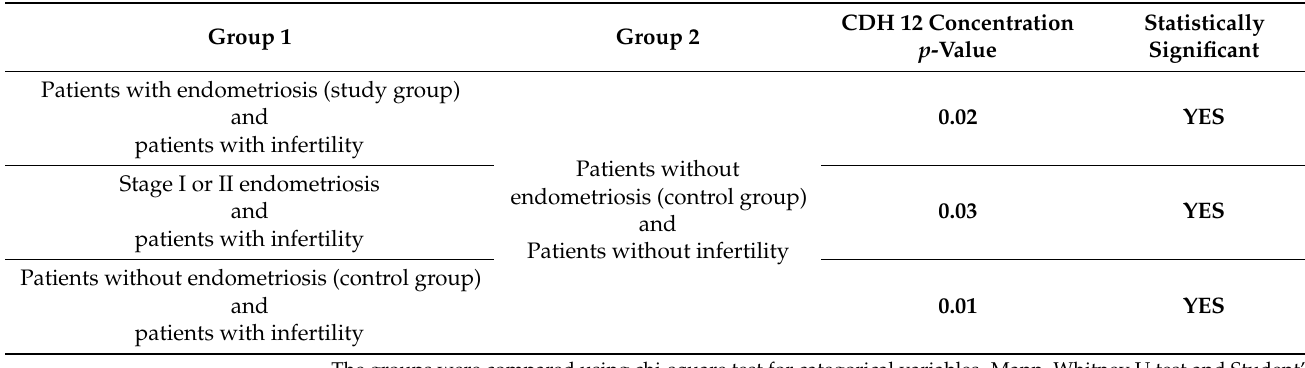
Table 3. Statistical significance of CDH12 concentrations between different groups (including patients with infertility).